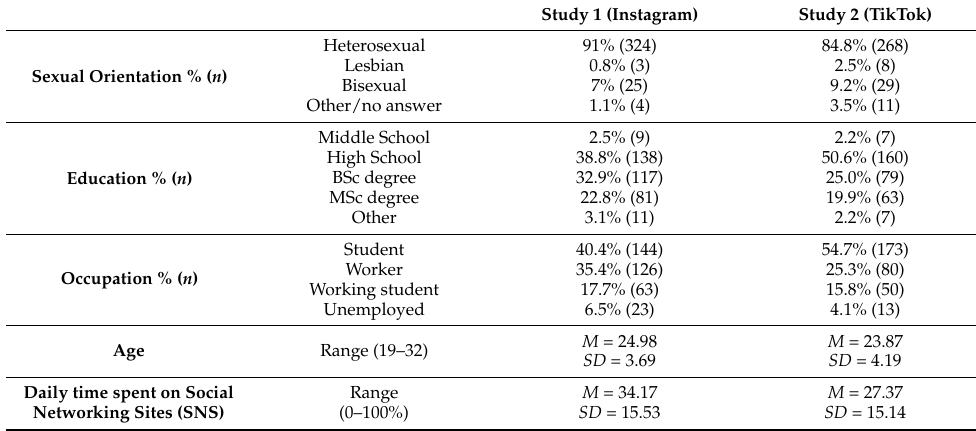
Table 1. Demographic Information of Study 1 and Study